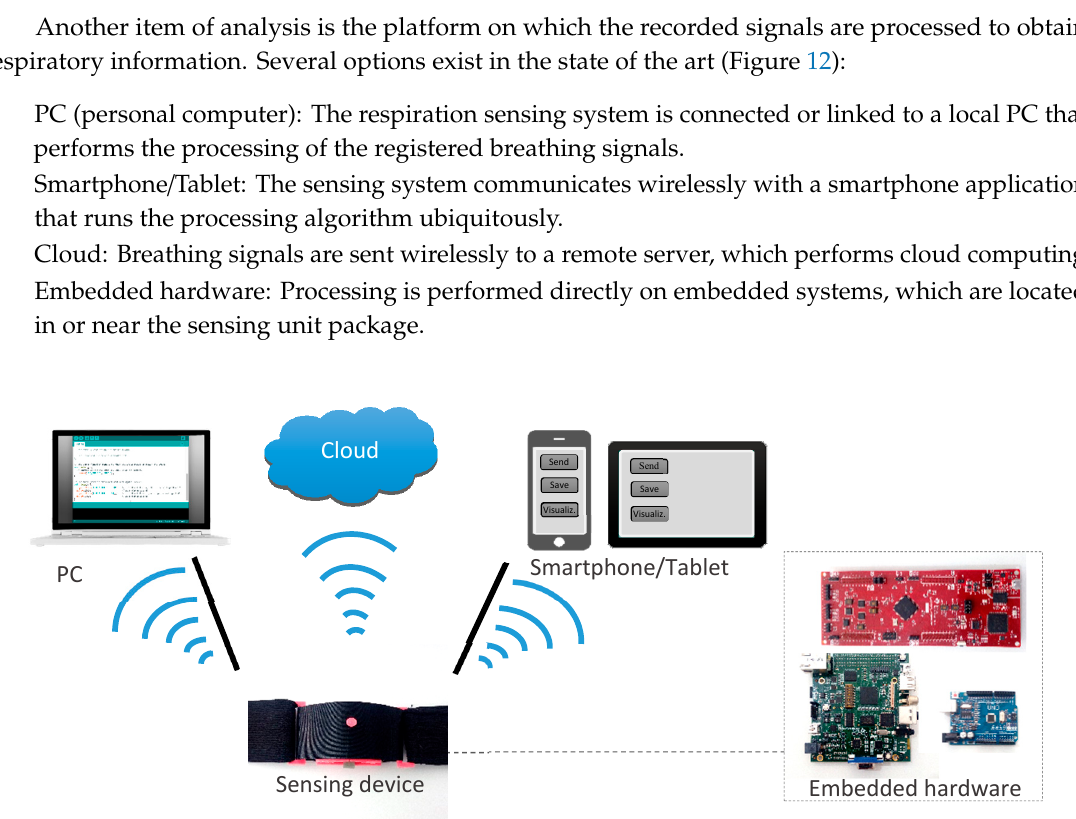
Figure 12. Representation of possible setups of respiratory sensing systems.